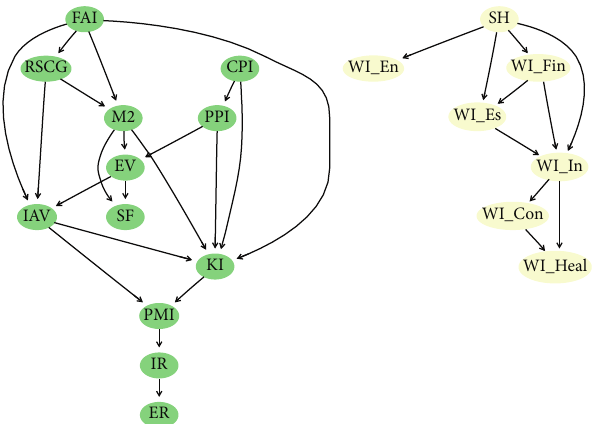
Figure 1: Bayesian network constructed from the entire